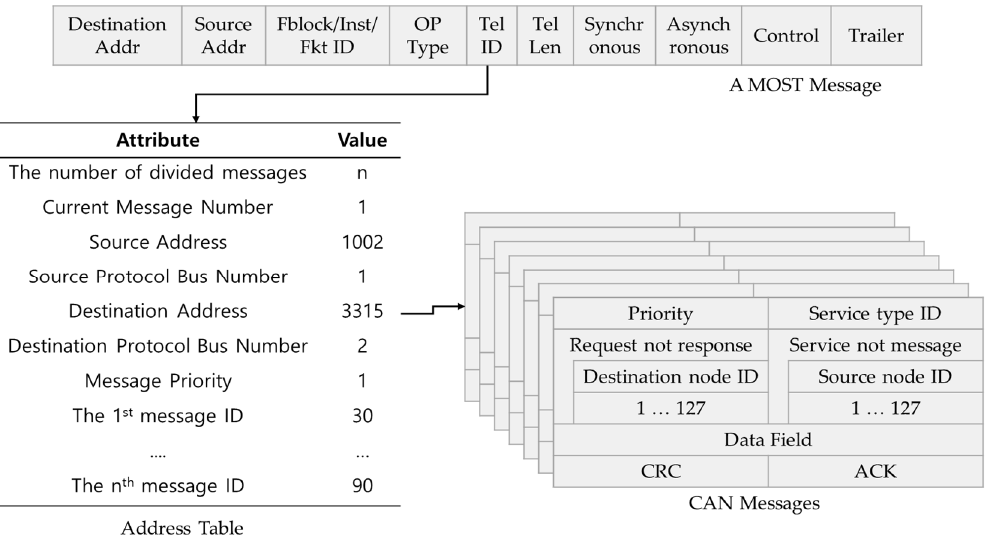
Figure 6. The conversion of a MOST message to CAN messages.